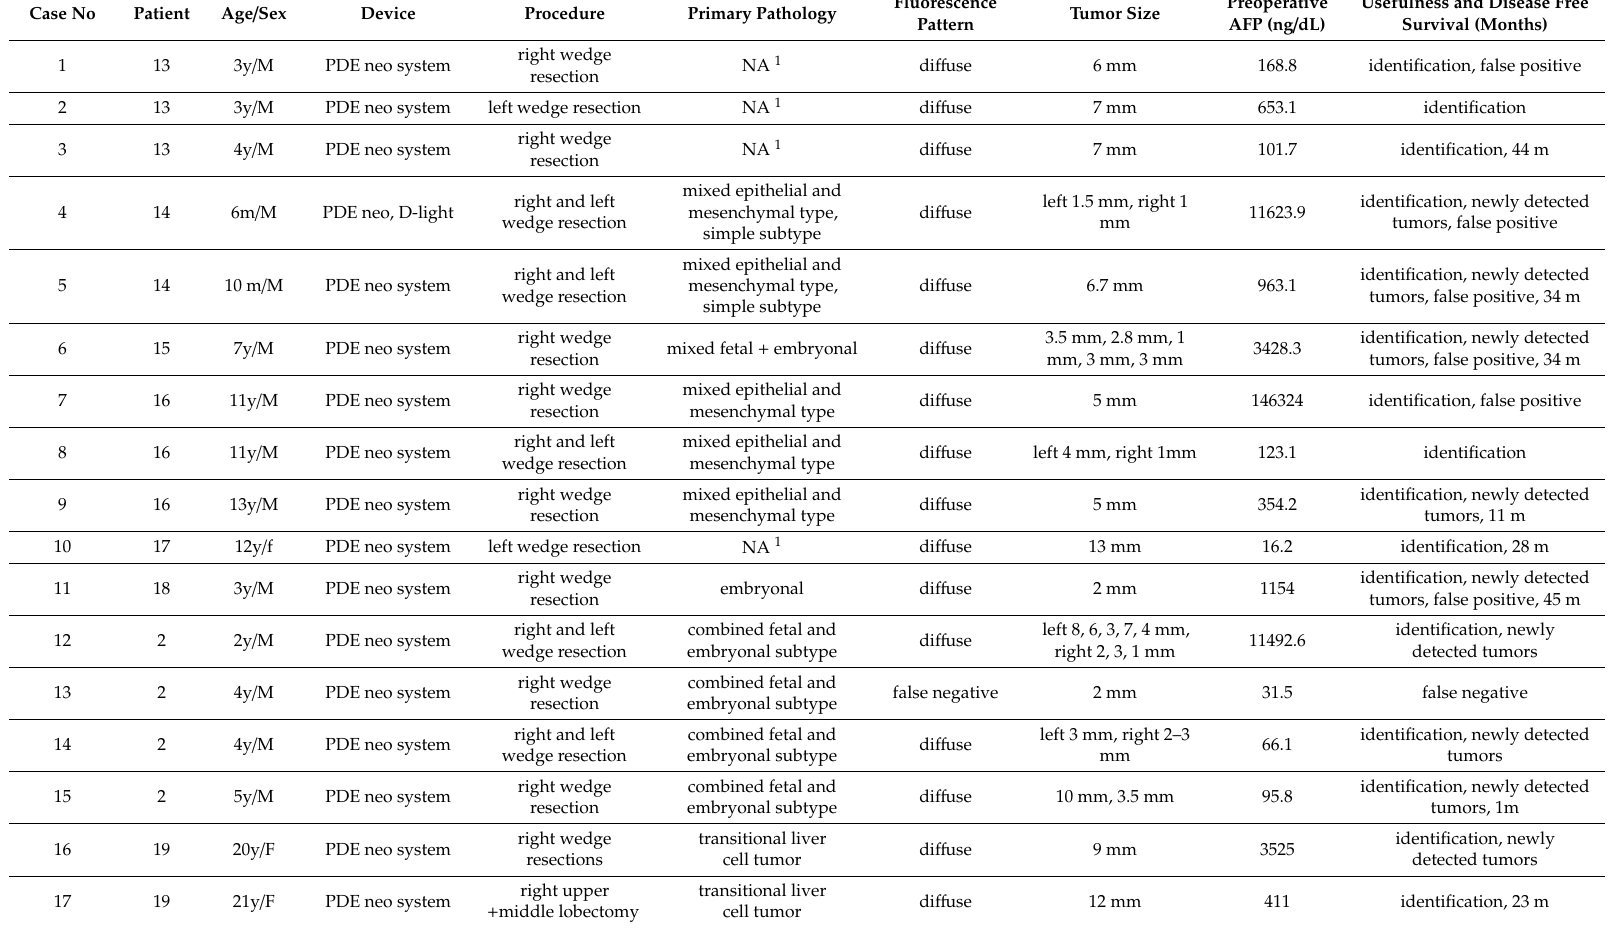
Table 2. Seventeen thoracotomies for eight patients with pulmonary